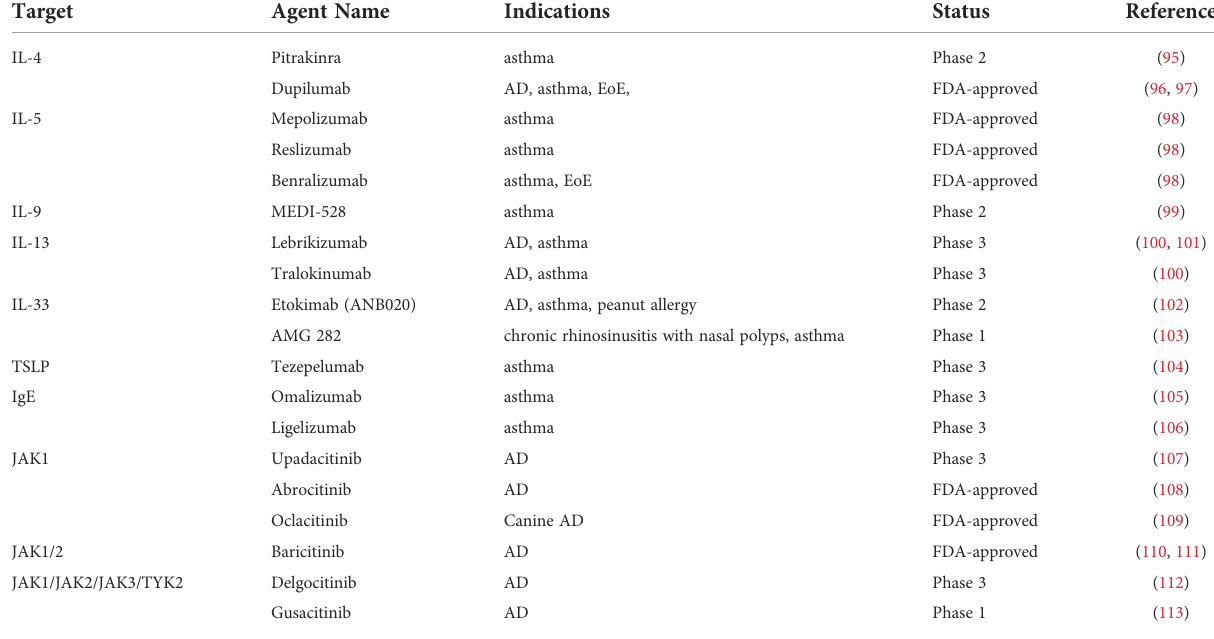
TABLE 1 Drugs targeting Th2A